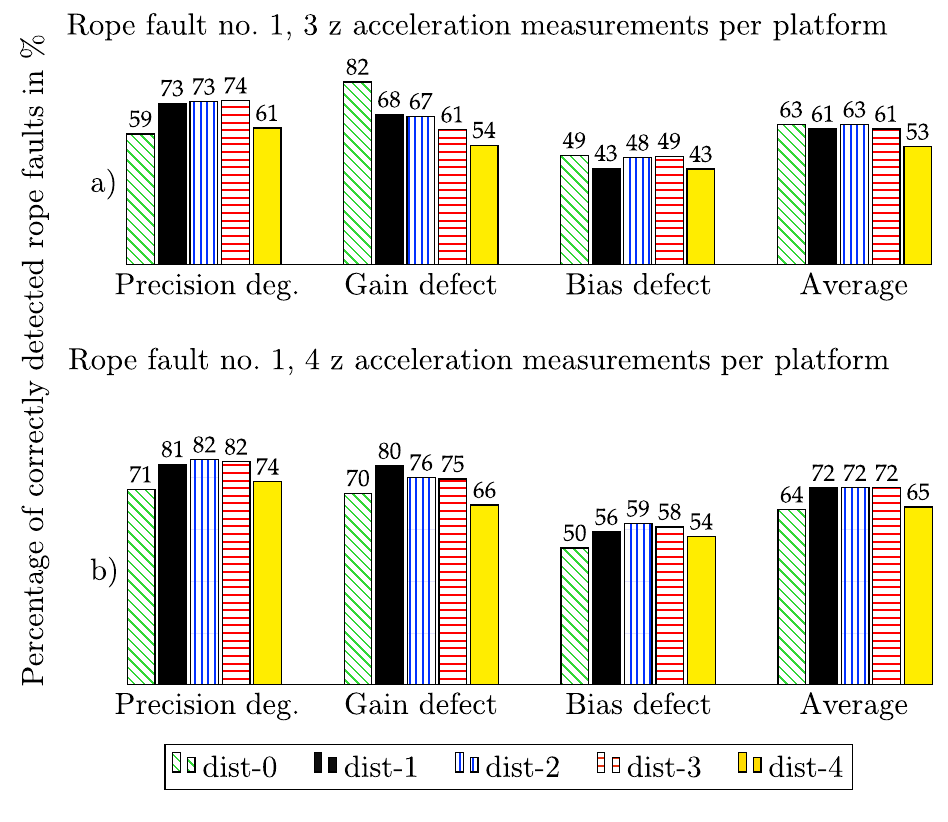
Figure 15. Percentage of correctly detected rope faults depending on the distance between defect sensors and the rope faults for a rope fault in rope number 1. ( a ) 3z acceleration sensors and ( b ) 4z acceleration sensors per platform are